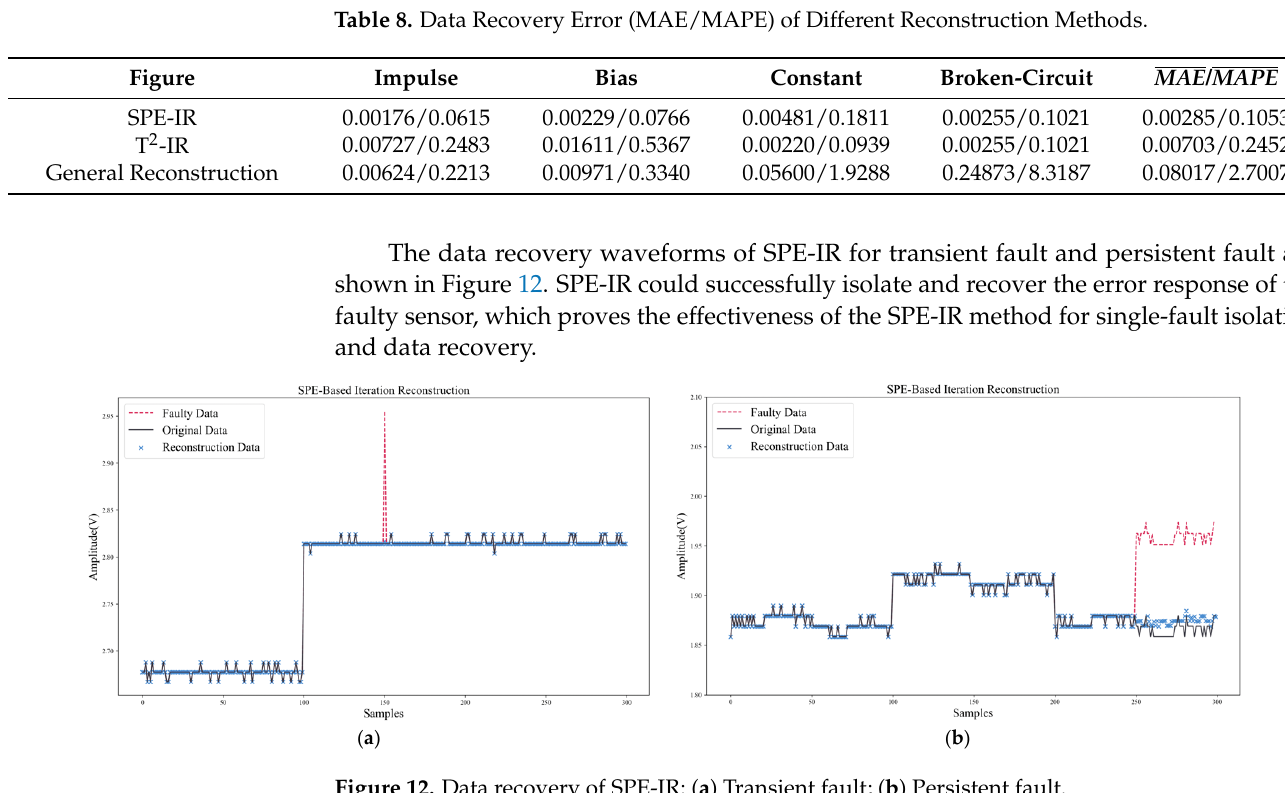
( b ) Figure 14. Data recovery of RVM: ( a ) Transient fault; ( b ) Persistent fault.